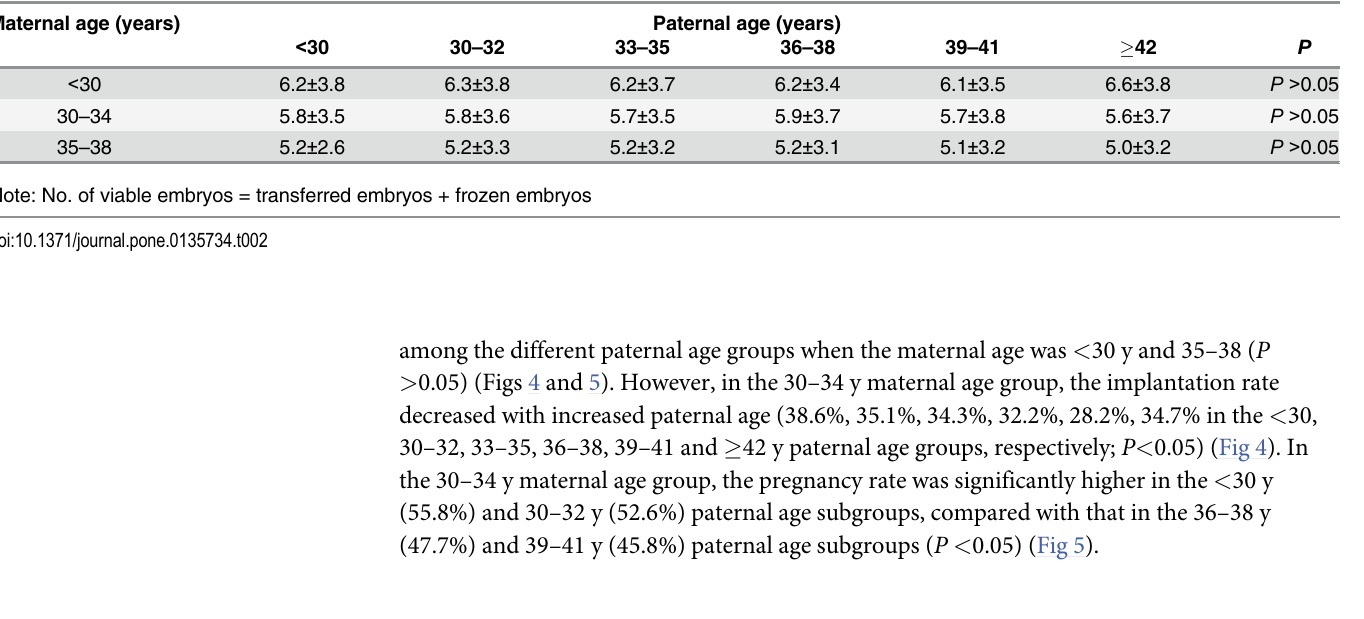
Table 2. Number of viable embryos in different age groups.